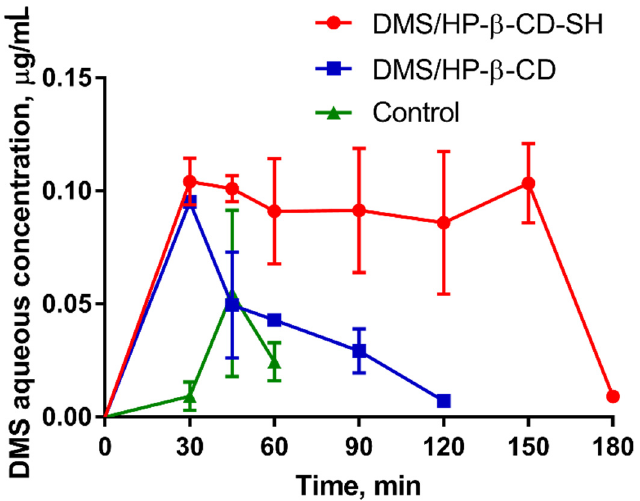
Figure 8. Profiles of DMS pharmacokinetics in the aqueous humour of rabbits following instillation of one eye drop (50 µ L) containing 0.3% w/v DMS alone or DMS and 12.5% w/v of different CDs. Each point is the mean ± SD of at least six values. Table 2. Pharmacokinetic data in the aqueous humour following instillation of one eye drop (50 μ L) containing 0.3% w/v DMS or 0.3% w/v DMS and 12.5% w/v of different CD.